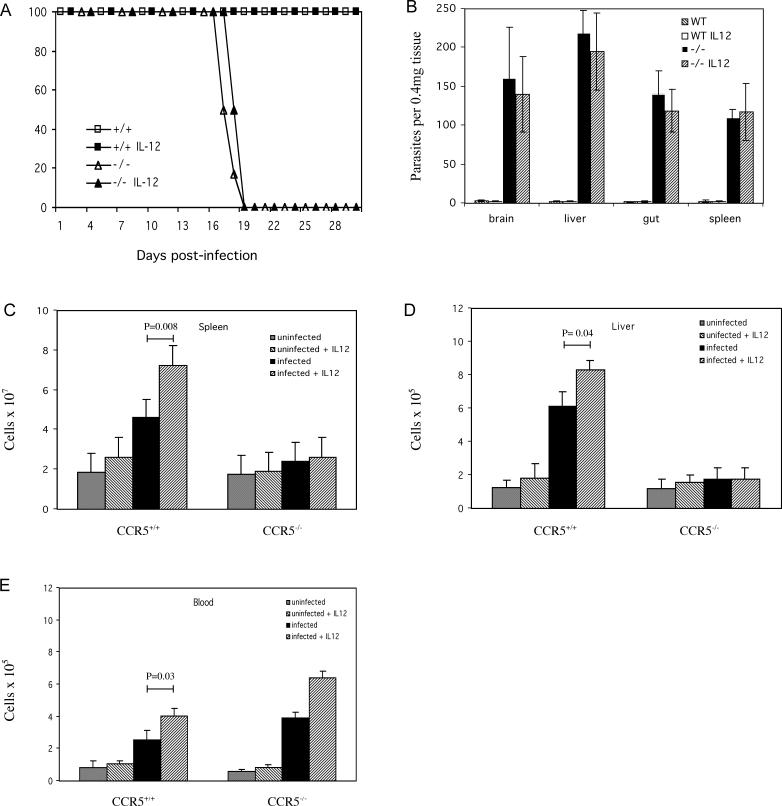
Survival and NK Cell Response following Exogenous IL-12 Treatment of CCR5+/+ and CCR5−/− Mice(A and B) Effect of IL-12 administration on survival in the C57BL/6 x129 background. CCR5−/− and CCR5+/+ mice (three mice per group) were treated with recombinant murine IL-12 (0.33 μg/mouse) daily intraperitoneally starting one day prior to infection with T. gondii. Uninfected controls treated with either IL-12 or saline were included in the study (six mice per group). Mice were challenged orally with 50 cysts and survival was monitored daily. Parasite load (B) was determined for mice described in (A). Mice were sacrificed on day 14 PI (three mice per group), and tissues (brain, liver, small intestine, and spleen) analyzed for parasite load by competitive DNA PCR.(C–E) Effect of exogenous IL-12 treatment on the NK cell response. CCR5−/− and CCR5+/+ mice were infected orally with the 76K strain of T. gondii (three mice per group) and were treated with recombinant murine IL-12 (0.33 μg/mouse) via intraperitoneal route starting one day prior to infection. Uninfected controls treated with either IL-12 or saline were included in the study (three mice per group). At day 7 PI, single-cell suspensions from the spleens (C), and lymphocytes from liver (D) and blood (E) were prepared and cells were analyzed for the expression of the NK1.1 marker by FACS (experiment was performed twice with similar results).